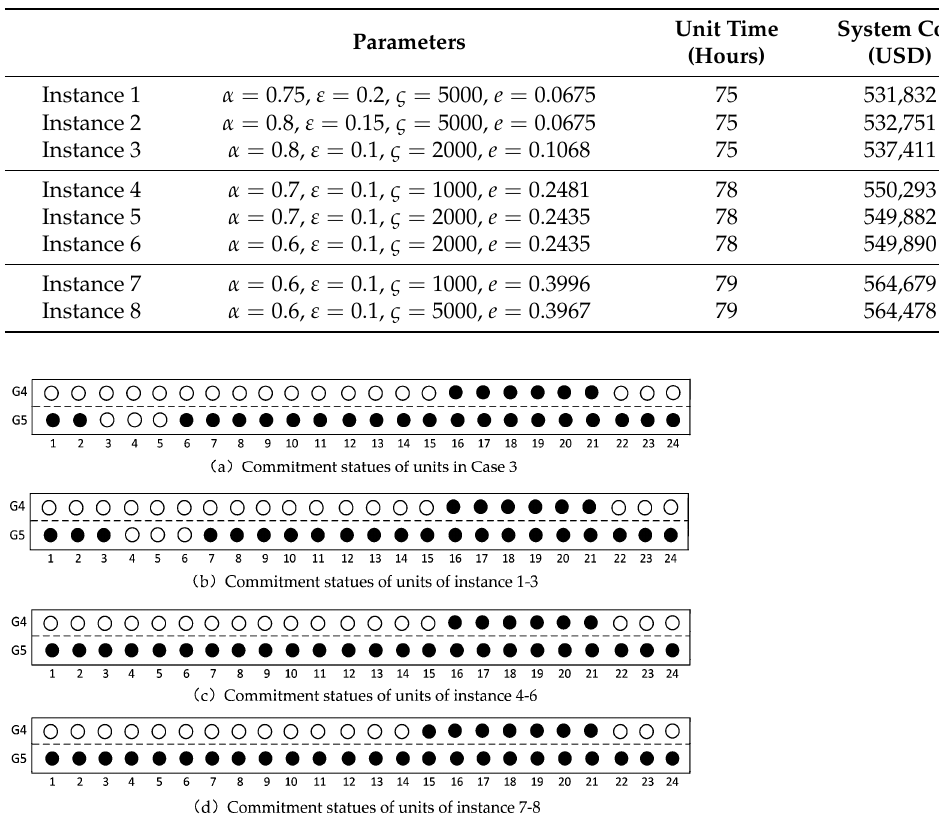
Figure 14. Commitment status of units.